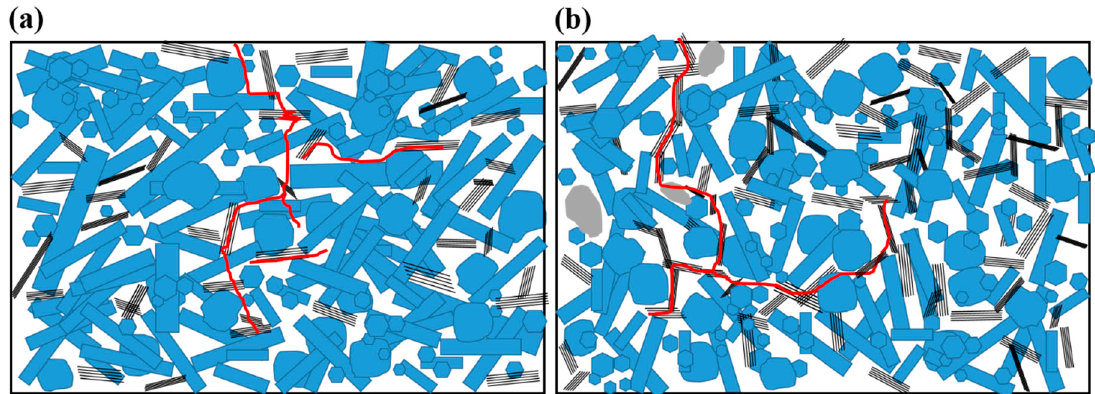
Figure 8. The crack propagation paths in Si 3 N 4 /MLG composites. ( a ) With 5 wt.%, ( b ) with 30 wt.%.